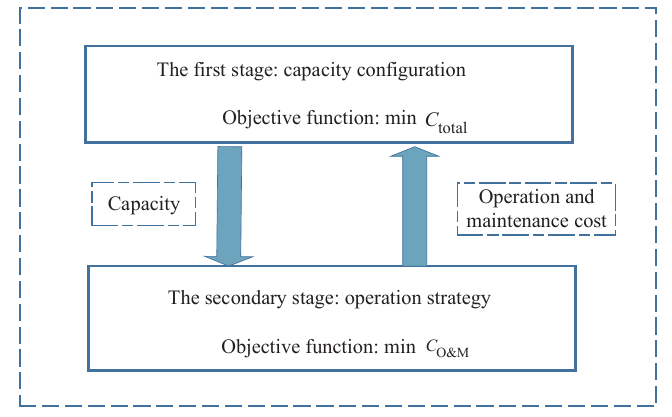
Figure 2. Diagram of the two-stage optimal